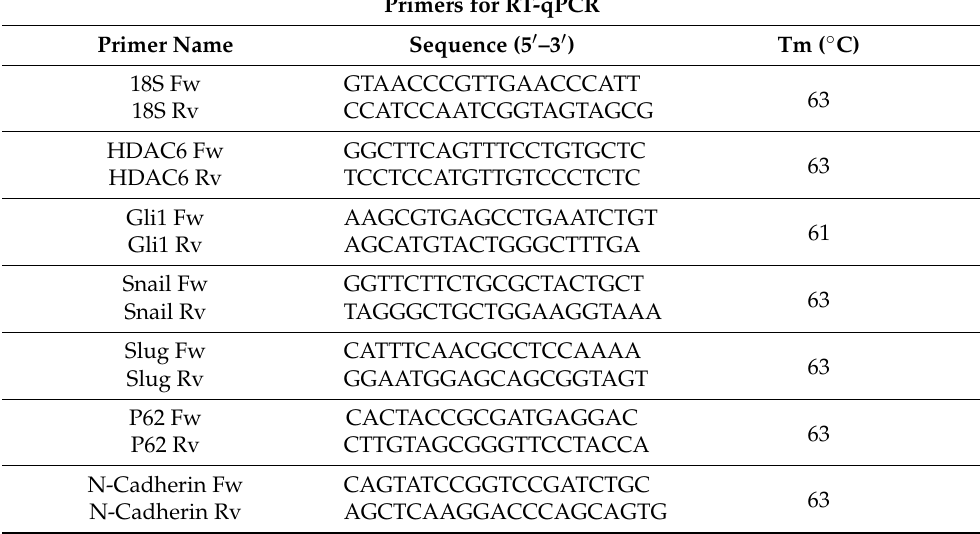
Table 1. Sequence of primers used for